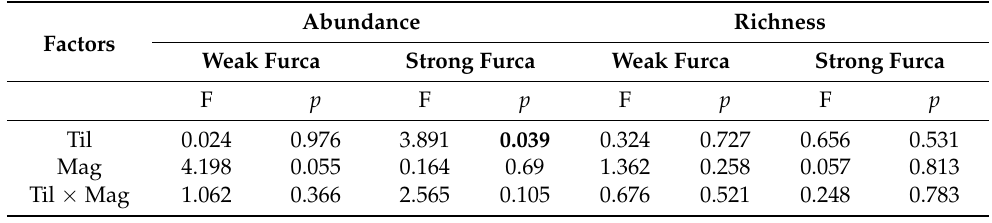
Table 1. Results of analysis of variance (ANOVA) of the effects of tillage type and crop rotation on the Shanon index, Simpson index, and Pielou index of Collembola communities.